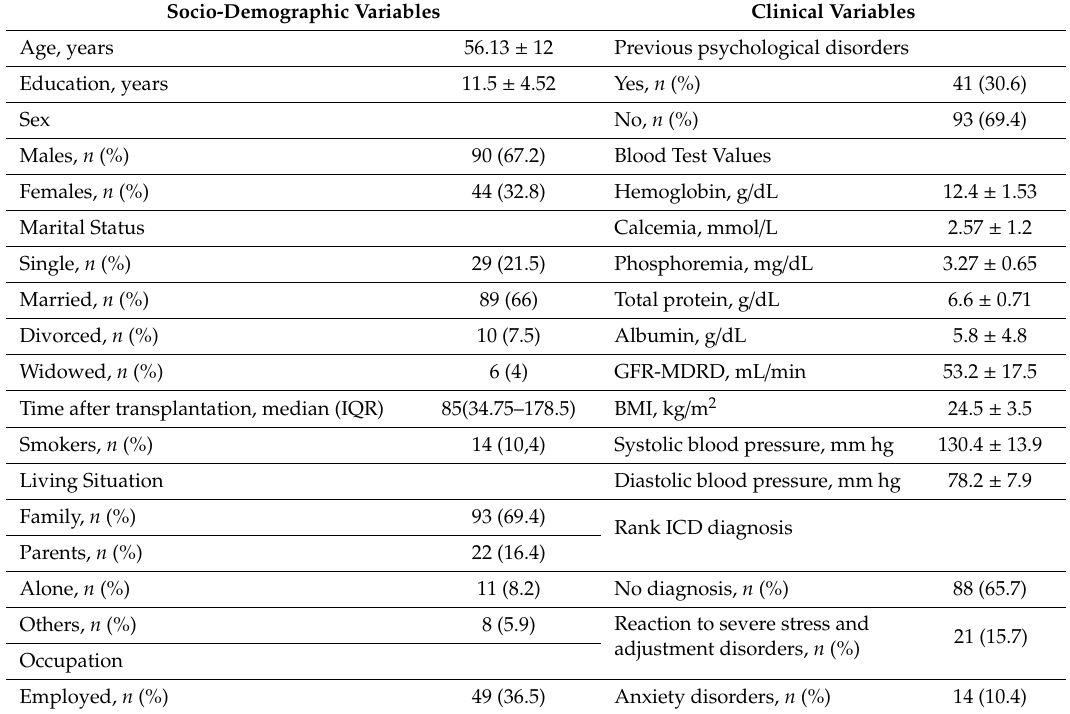
Table 1. Socio-demographic and clinical variables of the